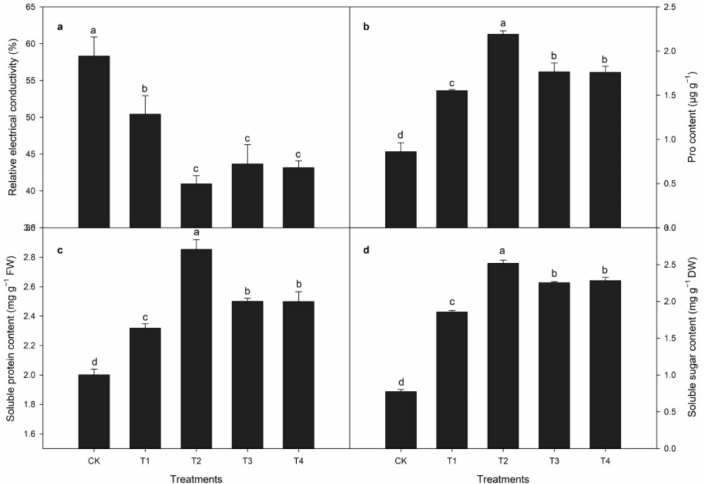
Figure 5. Effects of CaCl 2 treatment on the ( a ) relative electrical conductivity; ( b ) proline content; ( c ) soluble protein levels; and ( d ) soluble sugar content in Rosa hybrida under heat stress treated with 50 µ M CaCl 2 (T1), 100 µ M CaCl 2 (T2), 150 µ M CaCl 2 (T3), 200 µ M CaCl 2 (T4) or H 2 O as the control (CK). Each vertical line shows the standard error ( n = 10). The values are described as means ± SD; different letters denote significant differences ( p < 0.05) according to Duncan’s multiple range tests.